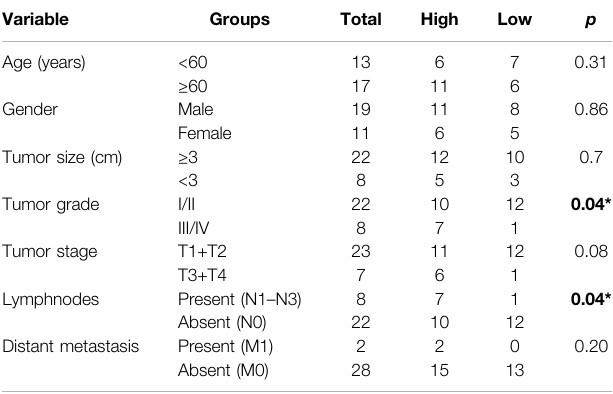
TABLE 2 | Relative expression of ABCA12 and clinical features of patients. Variable Groups